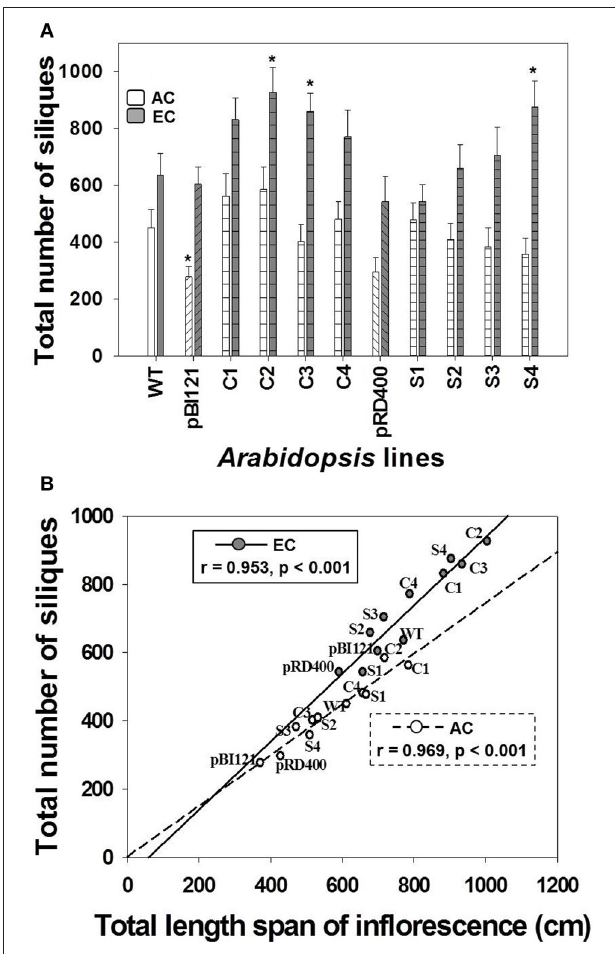
FIGURE 5 | Silique production in Arabidopsis lines grown at either AC or EC. The total number of siliques produced per plant (A) and its correlation with total inflorescence length (B) is given. CO 2 treatments: 380 ppm (AC, white bars or open circles/dashed line), 700 ppm (EC, gray bars or closed circles/solid line). Asterisks ( * ) indicate results significantly different from wild-type (WT) at α = 0.05. For (A) , values represent the mean ± SE; n = 10 plants per line. For (B) , the Pearson correlation coefficients (r), significance level, and the lines of best fit are shown.